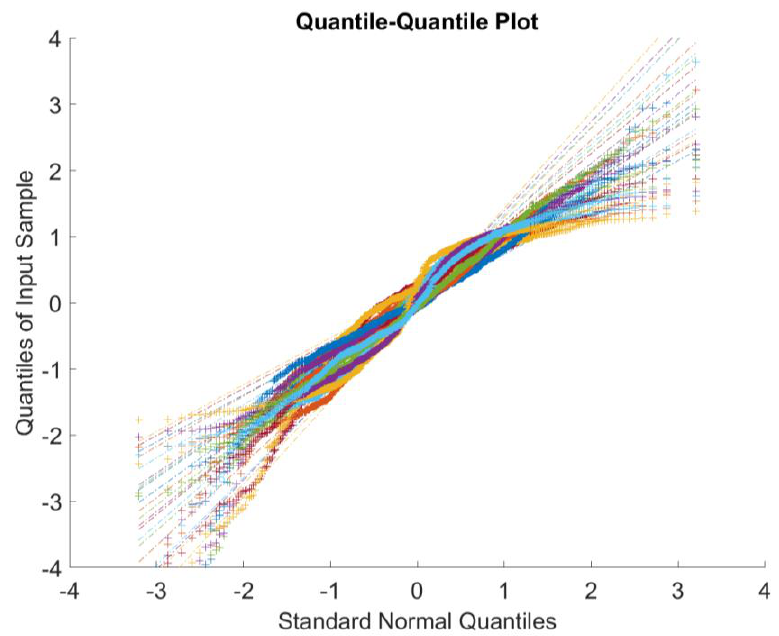
Figure 1. Plot of the Data Quantitles and Standard Normal Quantitles.